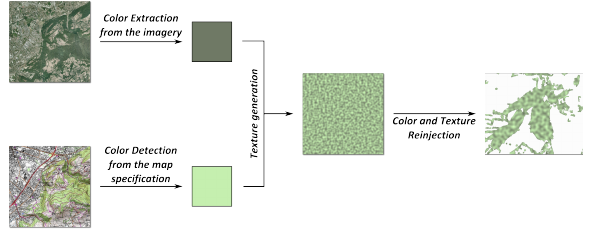
Figure 5: An example of procedural texture.